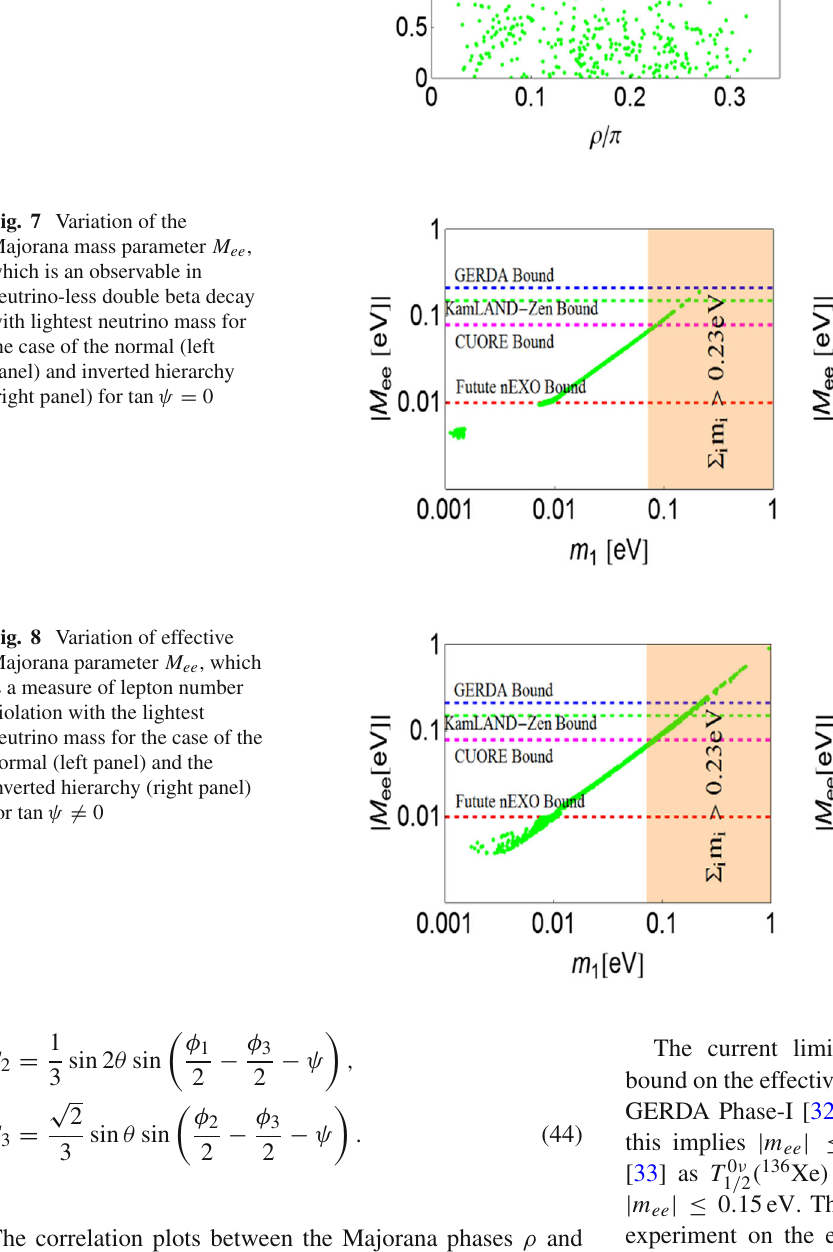
Fig. 6 Correlation plots between the Majorana phases σ and ρ for the case of the normal (left pane) and inverted hierarchy (right panel) for tan ψ (cid:13)= 0